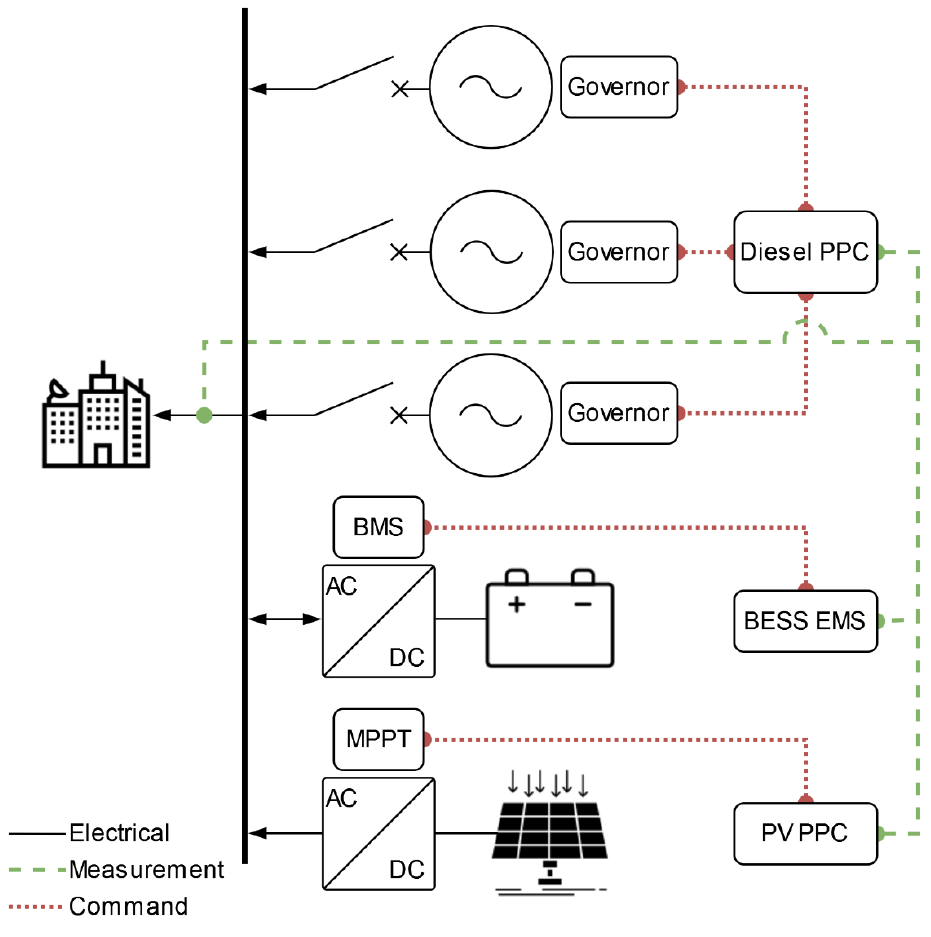
Figure 1. Configuration of an isolated hybrid microgrid.